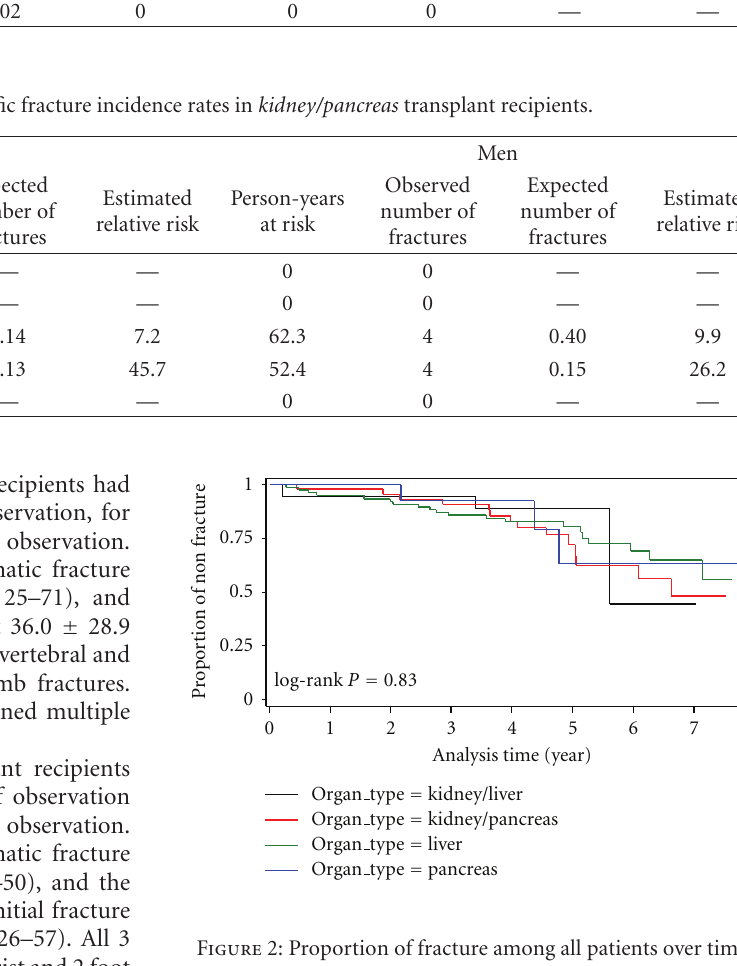
Figure 2: Proportion of fracture among all patients over